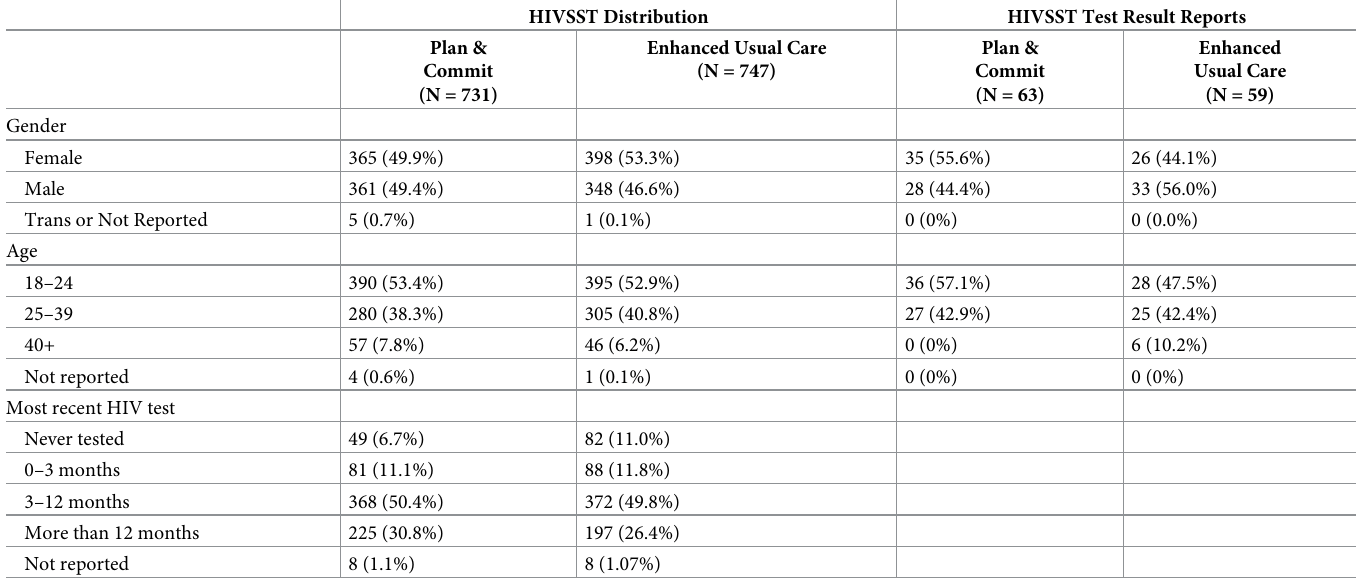
Table 1. Characteristics of recipients of HIV self-screening tests (HIVSST) and those reporting test results via WhatsApp messaging, Tshwane Metropolitan Munic- ipal District, 2019.